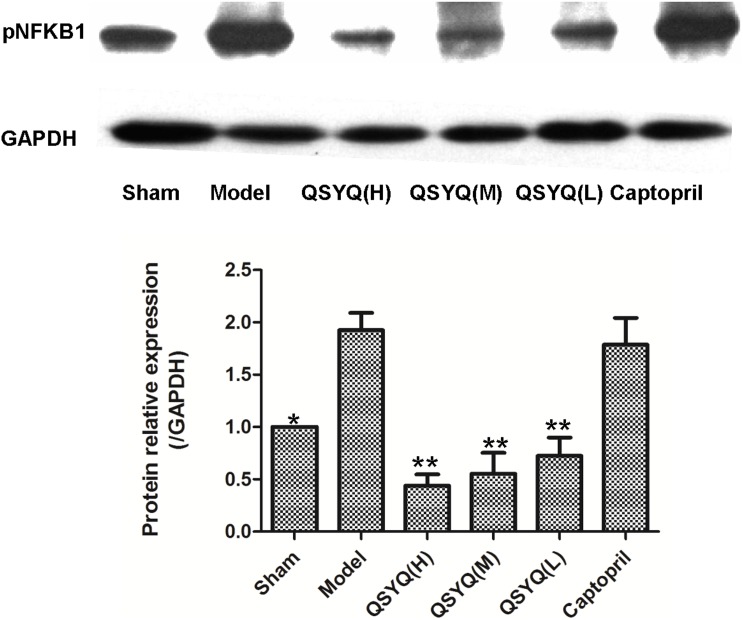
QSYQ significantly decreased cell signal transduction pathway factors of pNFKB1 in rats with HF.pNFKB1 in model group increased compared with sham, while treated by QSYQ (H), (M) and (L) doses, the pNFKB1 level was significantly decreased. In captopril group, the level of pNFKB1 had no statistical significance compared to model group. n = 10∼14 for each group. Data were analyzed by one-way ANOVA, with p<0.05 indicating statistical significance. *Differed significantly from the model group (p<0.05), **Differed significantly from the model group (p<0.01).